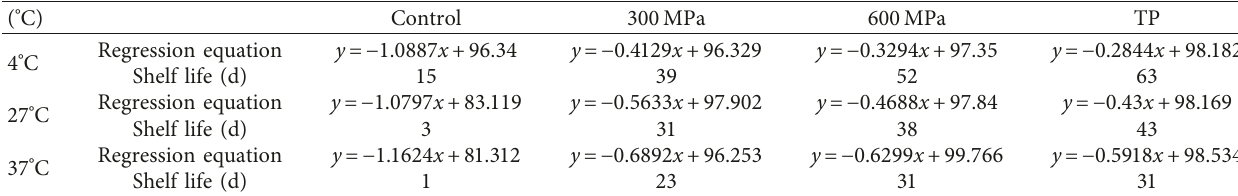
Table 2: Shelf life of samples under different treatment